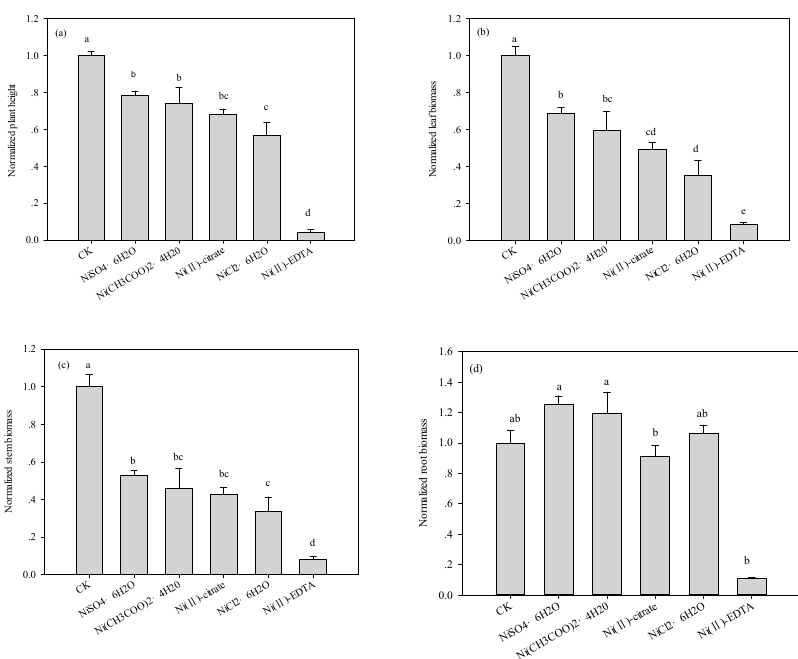
Figure 2. Effects of different Ni compounds added to the soil (1000 mg Ni·kg − 1 ) on the ( a ) plant height, ( b ) leaf biomass, ( c ) stem biomass, and ( d ) root biomass of maize seedlings at 28 days after emergence. The normalized values for different treatments were calculated in reference to the control (CK), and the error bars represent the standard errors of the means. Values with different letters are significantly different (Duncan multiple range test, p = 0.05).